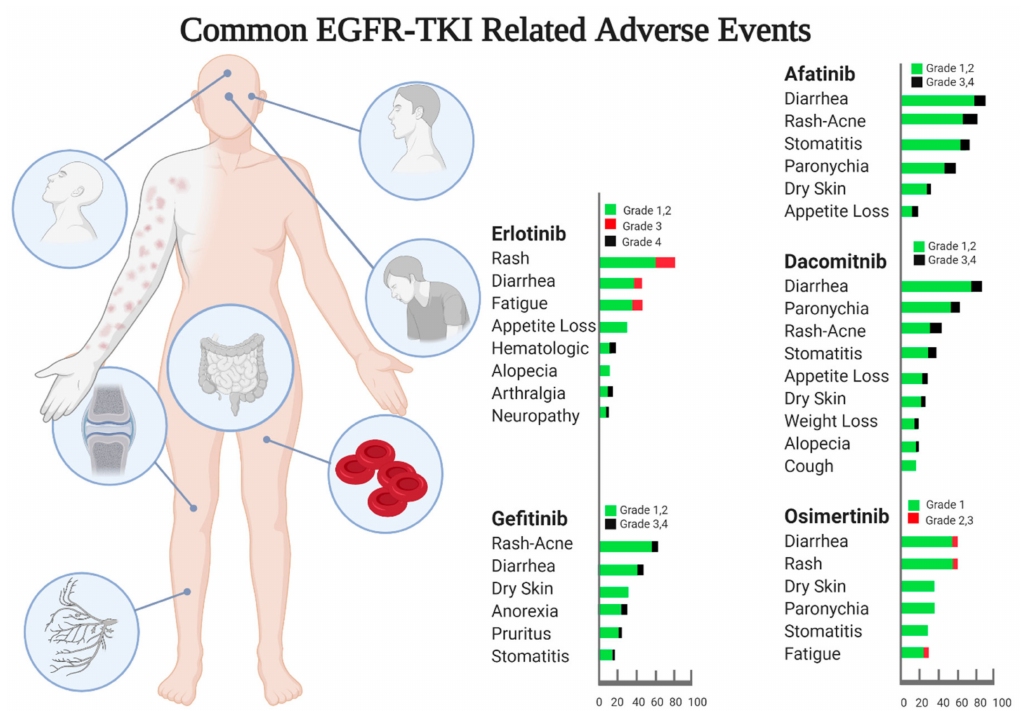
Figure 4. Common reported adverse events from phase 3 randomized clinical trials of EGFR TKIs in EGFR-mutated lung can- cer. These include first-generation: erlotinib [13], gefitinib [19], second-generation including afatinib [20], dacomitinib [23], and third-generation osimertinib [25] EGFR TKI